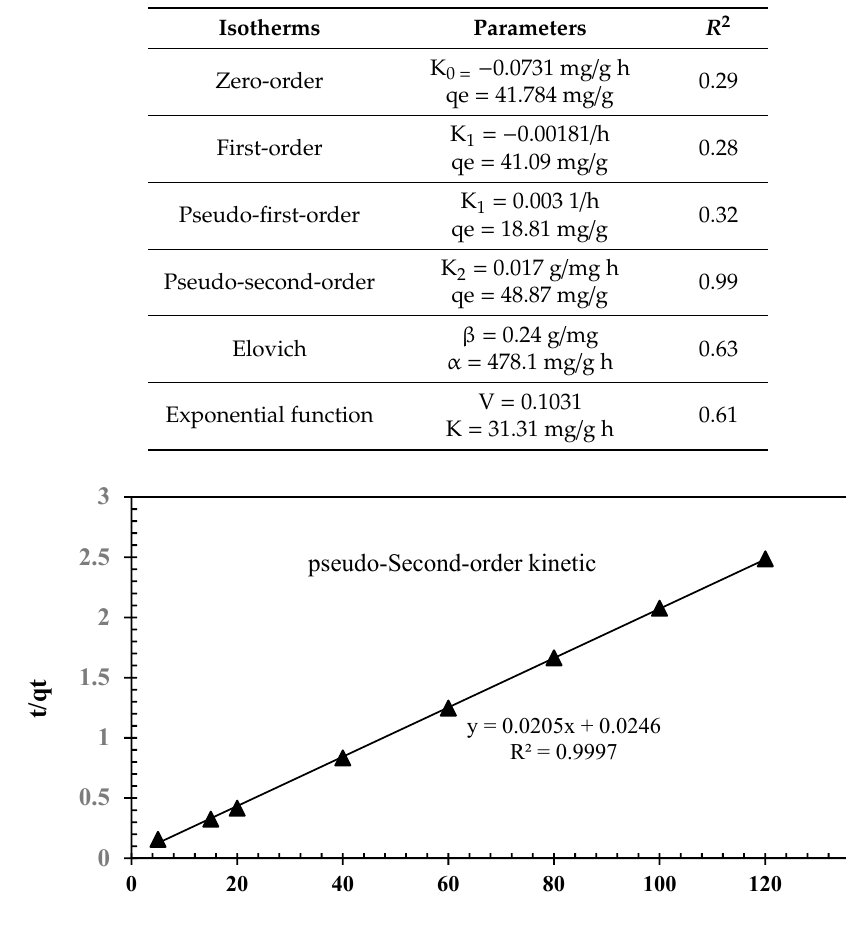
Table 6. Kinetic parameters for arsenic removal using synthesized iron nanoparticles.